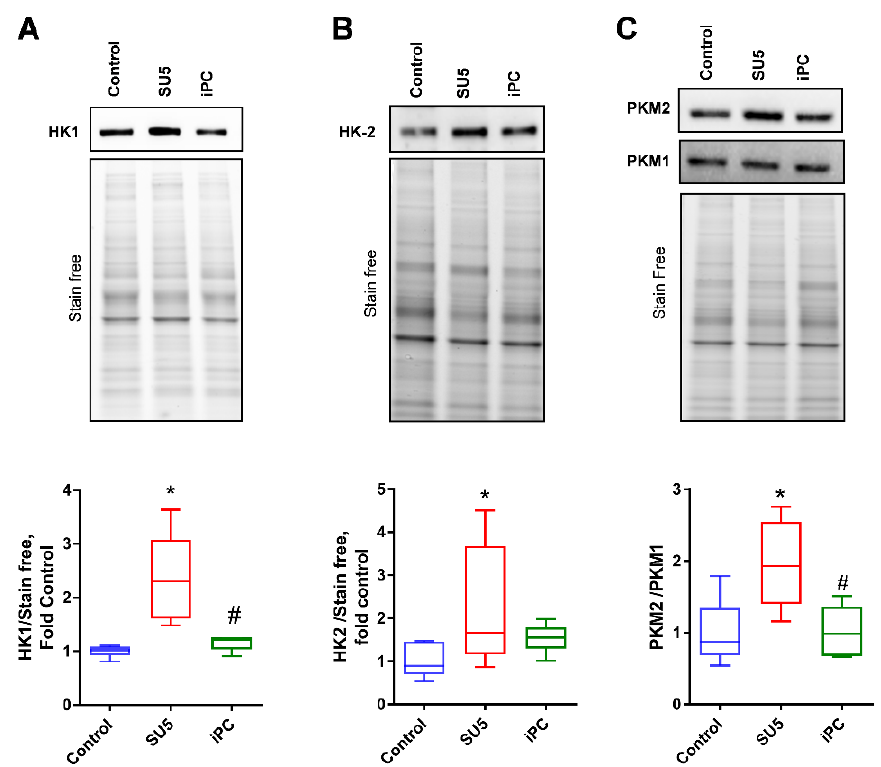
Figure 3. PC inhibitor attenuated increased glycolysis in PAH. Glycolytic enzymes ( A ) hexokinase-1 (HK1), ( B ) hexokinase-2 (HK2), and ( C ) pyruvate kinase 2 (PKM2), but not PKM1 showed increased expression in the SU5 PAH model. PC inhibitor treatment significantly attenuated glycolytic enzymes expression back to normal. Data expressed as box-and-whisker plot with median value ± min max, N = 5–6, * p < 0.05 versus control, # p < 0.05 versus SU5 by ANOVA.